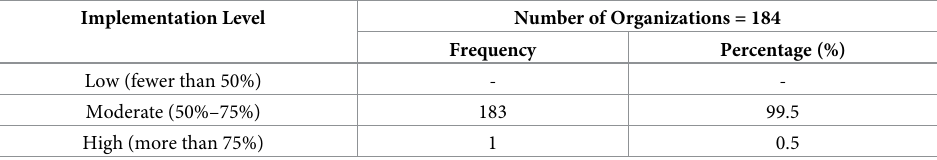
Table 6. Distribution of nonprofit organizations’ according to their implementation level of partnering life cycle